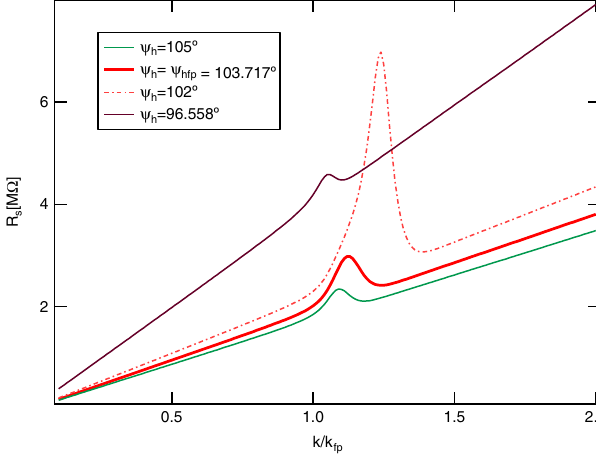
FIG. 15. Shunt impedance vs harmonic voltage ratio normal- ized to the flat potential voltage ratio k cavity tuning angles. φ Þ ¼ V sin φ . MC ð rf